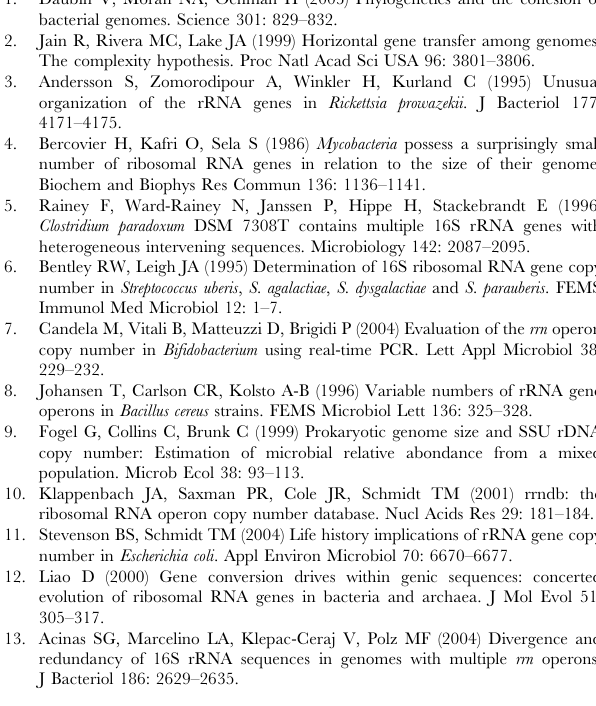
highlighted according to their r-cluster: dark blue, green or red filled circles for the aeruginosa, fluorescens or putida r-cluster, respectively (deduced from Bodilis et al, 2004, 2011). The unrooted dendrogram was estimated using the Neighbour-Joining algorithm from evolutionary distances computed according to the Jukes and Cantor correction. The colour of the symbol corresponds to the proposed positions of the sequences in the aeruginosa (blue circle), fluorescens (green circle) and putida (red circle) r-clusters. The positions of the 1803 sequences in the different r-clusters were the same when a Maximum Likelihood analysis was carried out, expect for three sequences (highlighted by yellow triangles). This phylogenetic tree is the same as those of the Figures 4, 5 and S8. Figure S8 Phylogenetic occurrence of the major V6 hypervariable motif. The phylogenetic tree was built from 1803 full-length 16S rRNA sequences of Pseudomonas available in the databases, after excluding the V1 region (see Fig. S7). The sequences highlighted by red circles have the only V6 motif found in at least two r-clusters (see Table